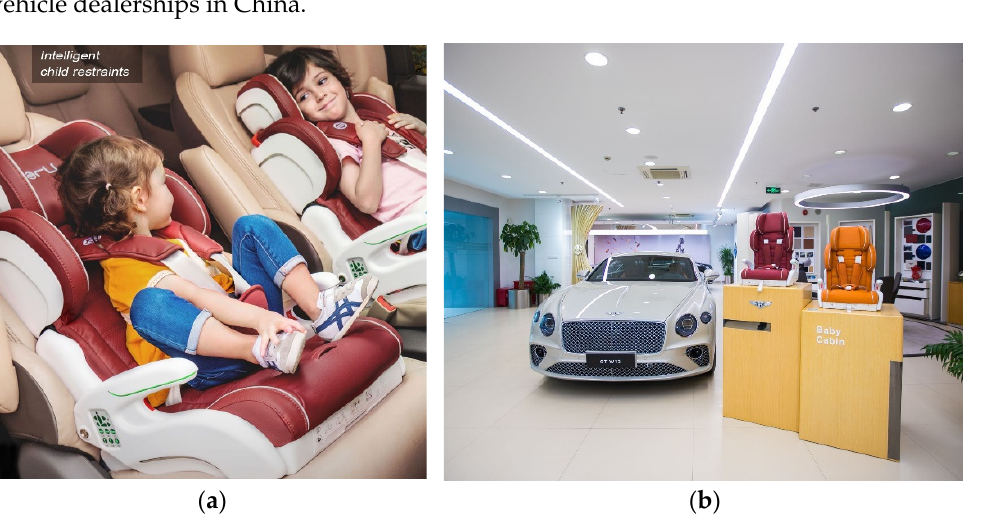
Figure 1. ( a ) Intelligent child restraints appearance; ( b ) Intelligent child restraints are sold in Shanghai Bentley automobile sales service shop.